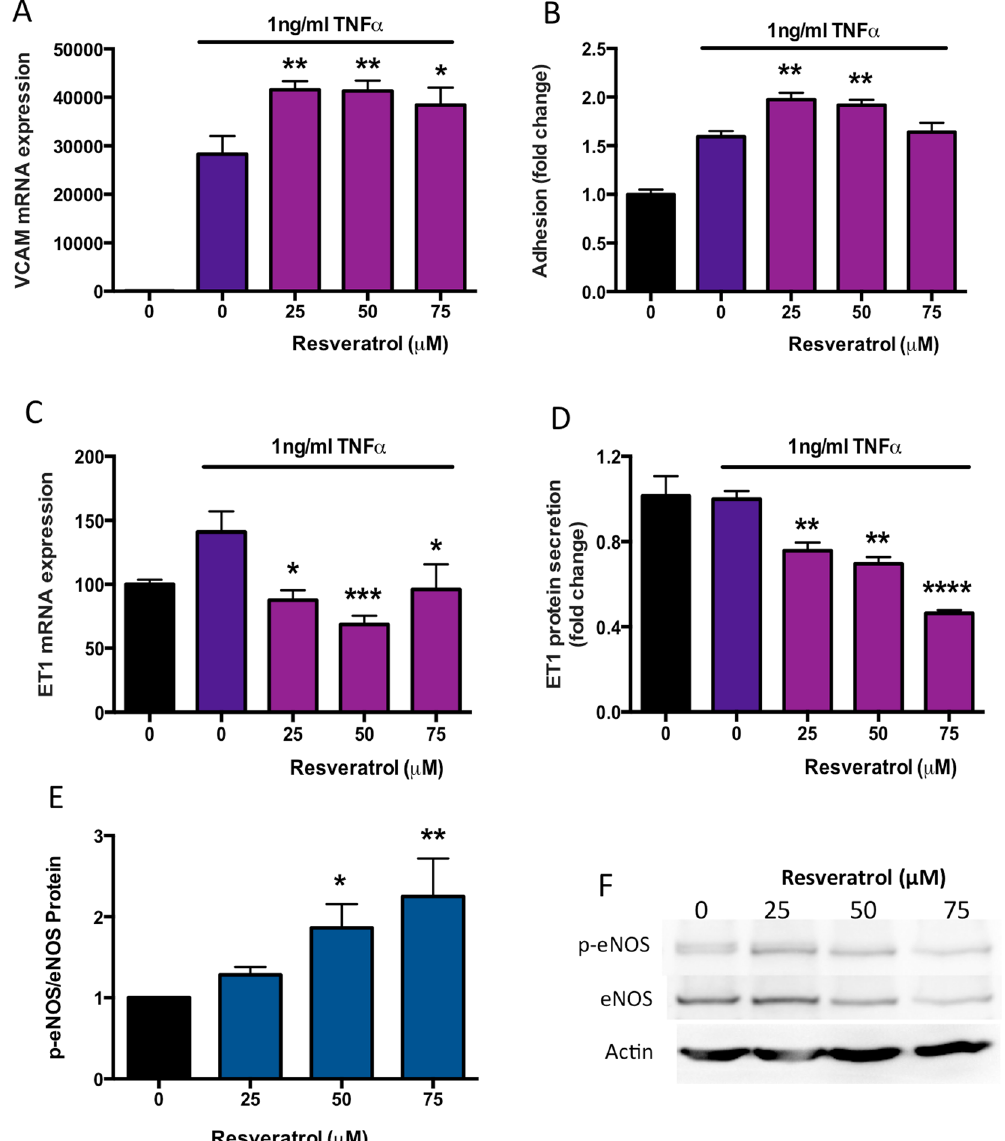
Figure 5. The effects of resveratrol on endothelial dysfunction. Preeclampsia is associated with significant endothelial dysfunction induced by a myriad of pro-inflammatory and anti-angiogenic molecules. In these experiments, we used TNF α to induce endothelial dysfunction in vitro . TNF α increased the mRNA expression of ( A ) VCAM1 300-fold beyond control, and this increase was further stimulated by resveratrol treatment. The increased expression in VCAM1 expression was reflected in the PBMC adhesion assay where ( B ) resveratrol significantly increased adhesion of PBMCs to TNF α treated HUVECs. Endothelin-1 is a potent vasoconstrictor elevated in the secretion of patients with preeclampsia. TNF α treatment increased ( C ) ET-1 mRNA expression, and this effect was returned to control levels by the addition of resveratrol. ( D ) Resveratrol also potently decreased ET-1 protein secretion from TNF α treated HUVECs. Finally we assessed the phosphorylation of eNOS (p-eNOS) to total eNOS protein levels in non-dysfunctional primary HUVECs treated with resveratrol. Western blot with densitometric analysis indicated that resveratrol significantly increased the peNOS/eNOS ratio in primary HUVECs ( E , F ). Data expressed as mean ± SEM. * p < 0.05, ** p < 0.01, *** p < 0.001 compared to TNFa alone (0 resveratrol). ( F ) Shows a representative western blot from n = 1 HUVEC experiment, whilst E depicts densitometric analysis of n = 3 separate HUVEC western blots. As indicated in the materials and methods, western blots were cut before antibody exposure and therefore cropped blots are displayed. N = 3–5 experimental replicates, with each n taken from a separate patient